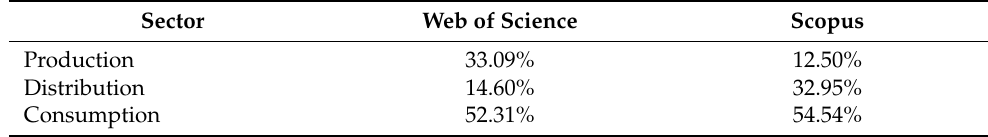
Table 13. Sectoral share of the number of publications in Web of Science and Scopus 1 .